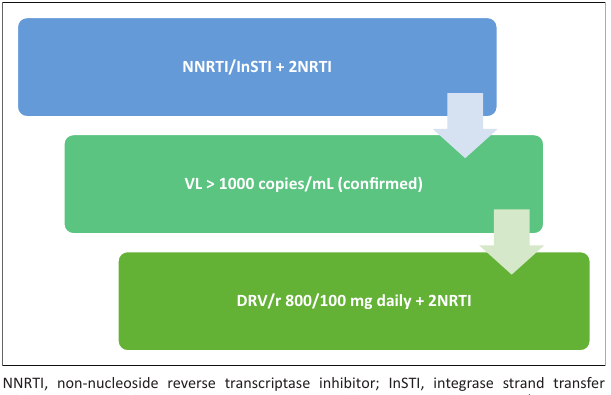
FIGURE 1: Patients failing non-nucleoside reverse transcriptase inhibitor- or integrase inhibitor-based first-line antiretroviral therapy.